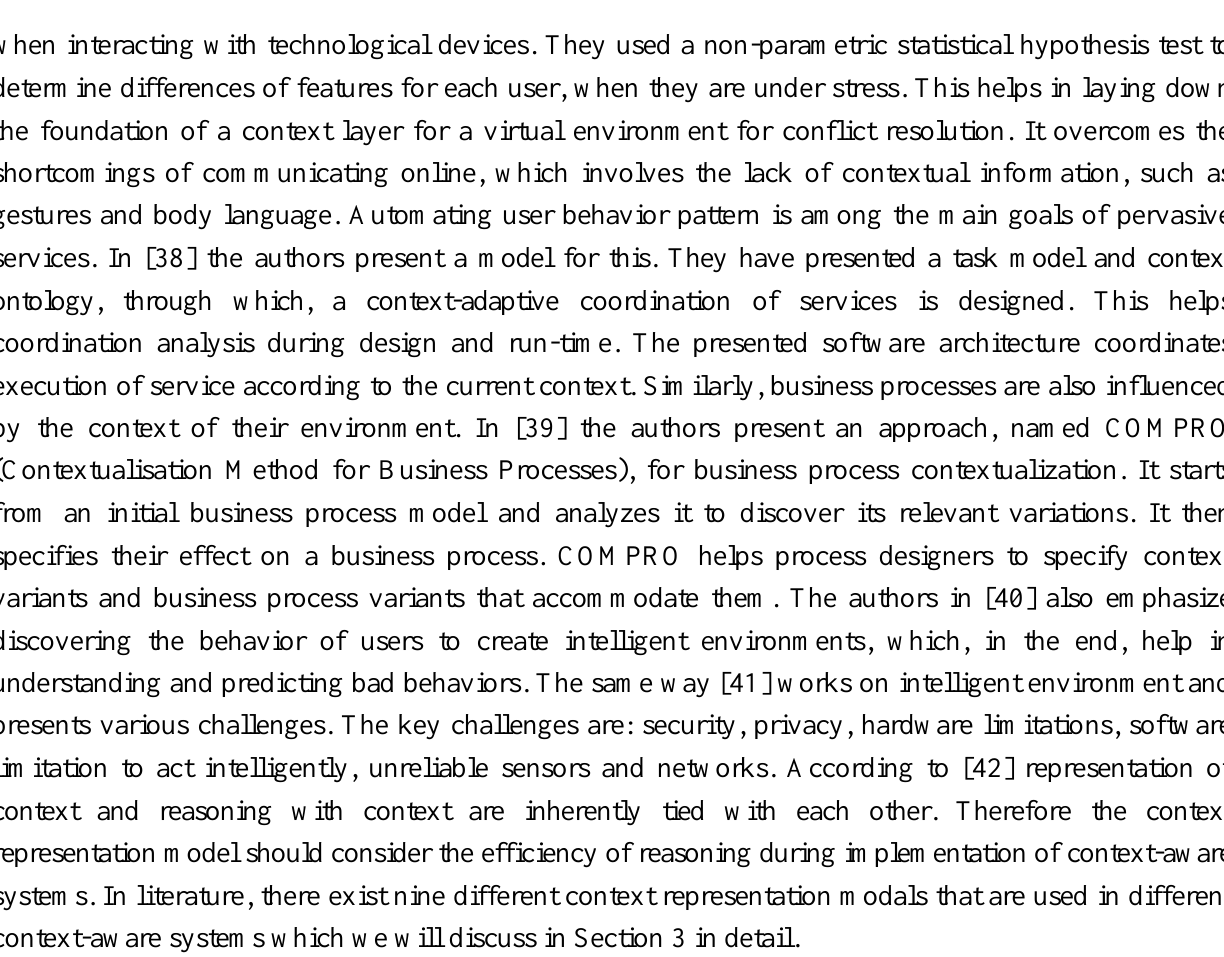
Figure 3. Representation of context information from three diverse input modalities including twitter, trajectory, and